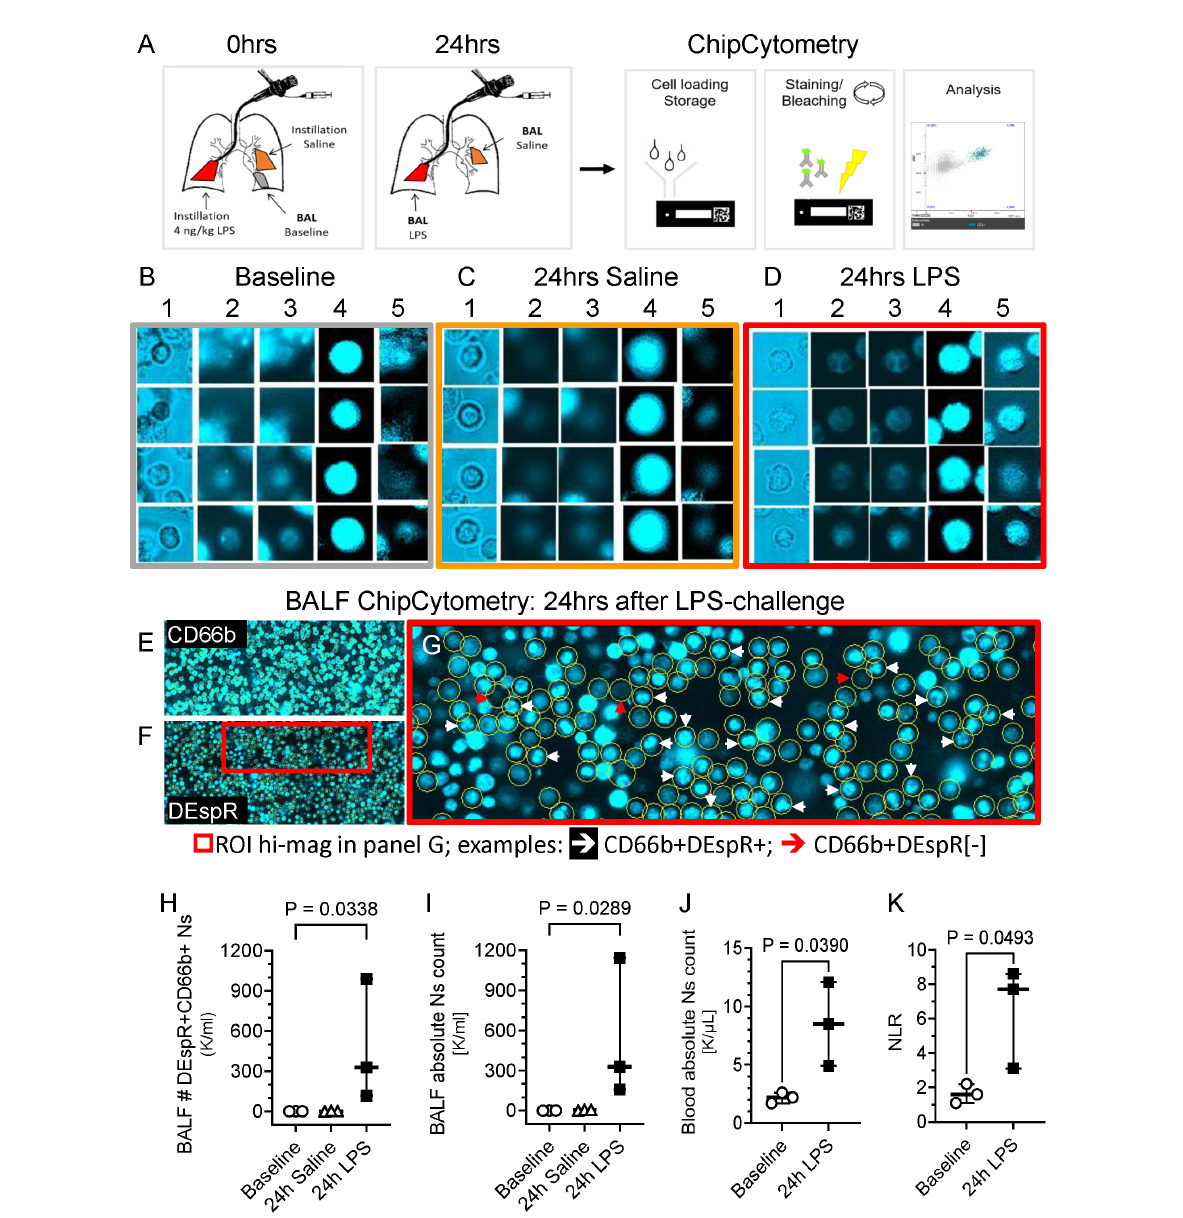
FIGURE 1 Representative ChipCytometry detection of DEspR+CD66b+ neutrophils. (A) Diagram of ChipCytometry analysis in the segmental LPS- challenge model to obtain segment-speci fi c human BALF cells at baseline (left lower lung), 24-hours after saline (right middle lobe) or LPS- challenge (left lingular lobe). (B-D) Representative ChipCytometry images from human healthy volunteers at baseline (B) , in lung segments with saline instillation (C) , and in lung segment with LPS-instillation (D) . Columns represent: 1] transmitted light, 2] auto fl uorescence in phycoerythrin (PE) and 3] Alexa-Fluor (AF)488 channels, 4] CD66b-PE immuno fl uorescence after subtraction of PE-auto fl uorescence, 5] DEspR-AF488 immuno fl uorescence after subtraction of AF488-auto fl uorescence. Transmitted and fl uorescence light images of four representative CD66b+ granulocytes are depicted for each. (E, F) Representative low magni fi cation images of ChipCytometry, after subtraction of auto fl uorescence signals, showing CD66b+ neutrophils (E) , and corresponding CD66b+DEspR+ neutrophils, wherein CD66b+ neutrophils are encircled (F) . Red boxed region of interest (ROI) shown in panel G in higher magni fi cation. (G) Representative image showing CD66b+ neutrophils (encircled in yellow) that are DEspR[-] red ( ↓ ) and DEspR+CD66b+ neutrophils with nuclear expression of DEspR white ( ↓ ). (H, I) Analysis of changes between baseline, 24-hours after segmental-saline and segmental-LPS challenge in BALF (H) number (#) of CD66b+DEspR+ neutrophils (Ns) and (I) BALF total # of neutrophils (Ns). (J, K) Analysis of changes between baseline and 24-hours (24h) post-segmental LPS-challenge in (J) peripheral absolute neutrophil (N) counts (K/ m L) in HVs and in (K) peripheral neutrophil-to-lymphocyte